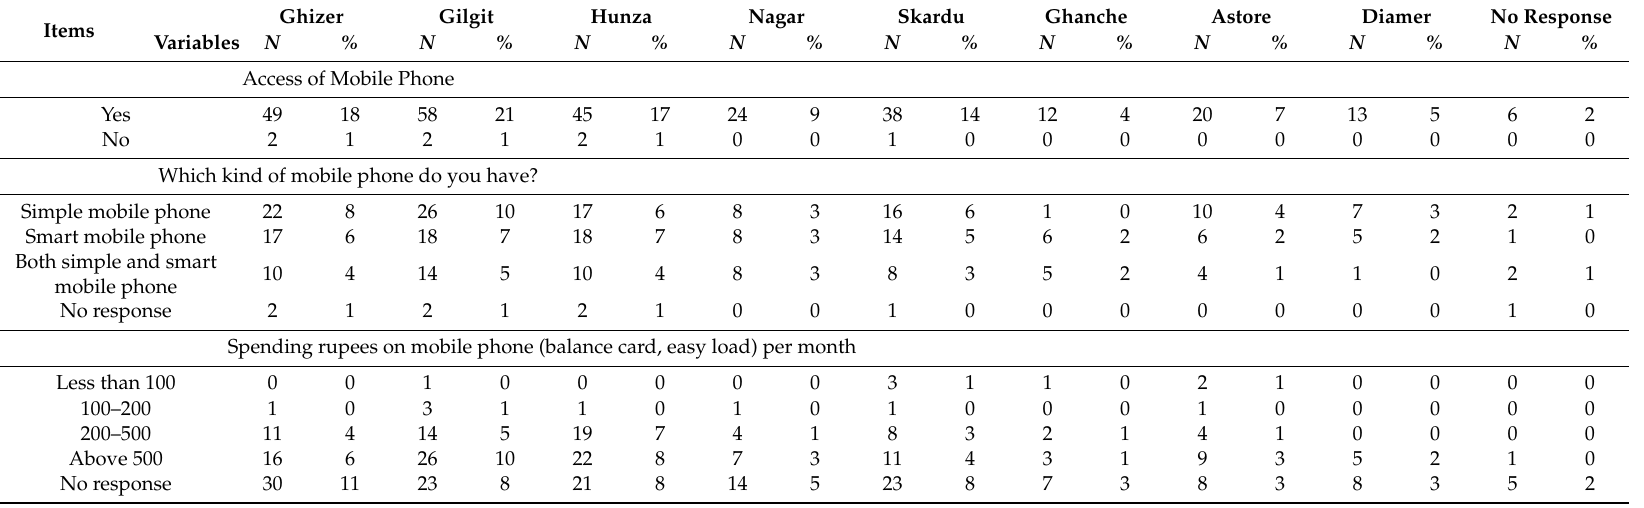
Table 2. Mobile phone access, types and money spent on mobile phones